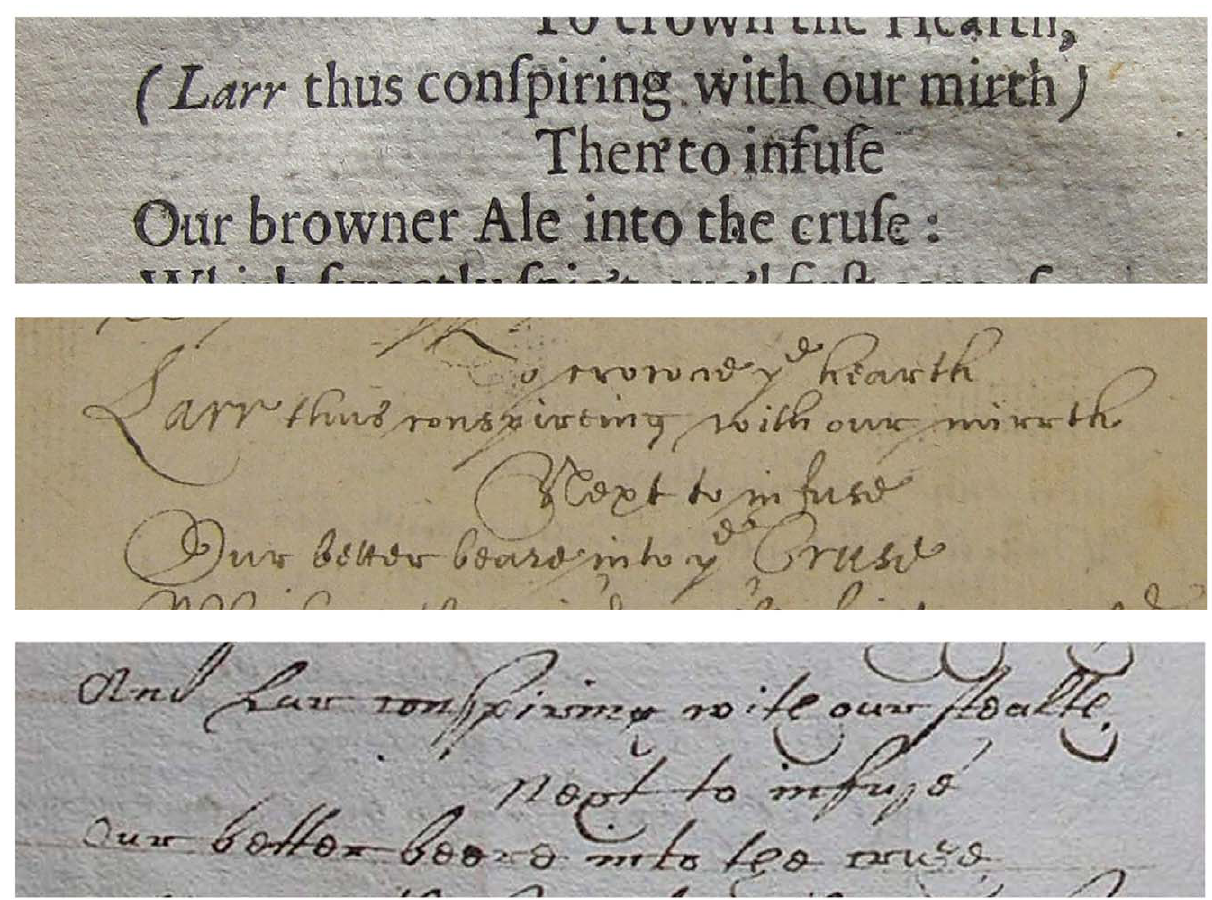
Figure 1. Extracts from the poem ‘‘His Age’’ by Robert Herrick. Figure 2 uses this piece of text as an example of the alignment process. Top panel (Hes in Figure 2) is a printed version from Hesperides, published in 1648 (copy owned by Professor Tom Cain). Middle panel (Ros in Figure 2) is from the Poetical Manuscript Commonplace Book MS 239/23, Rosenbach Museum & Library, Philadelphia. The bottom panel (SJC in Figure 2) is from a verse miscellany, MS S.23, by permission of the Master and Fellows of St John’s College, Cambridge.